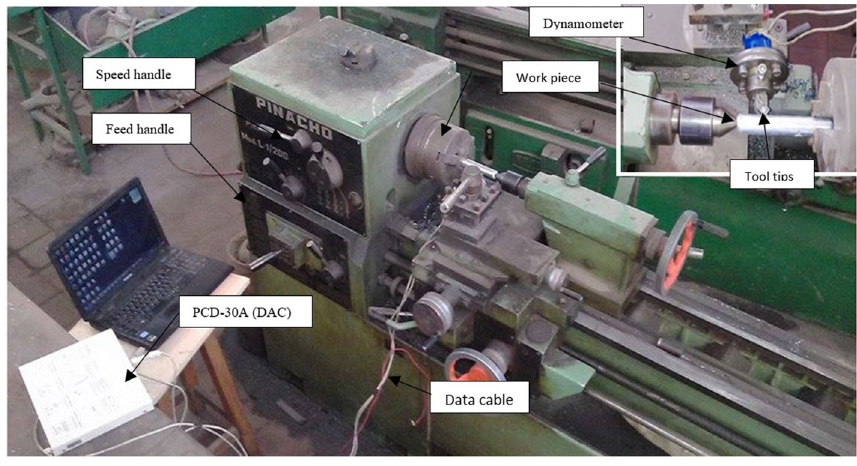
Fig. 3 Used experimental setup